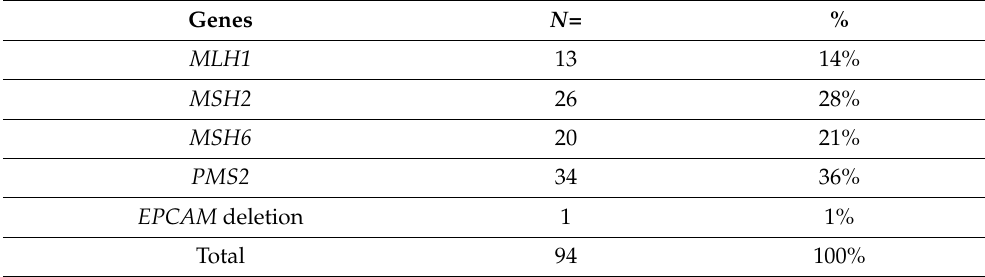
Table 3. Women carrying PVs in MMR Lynch syndrome genes.